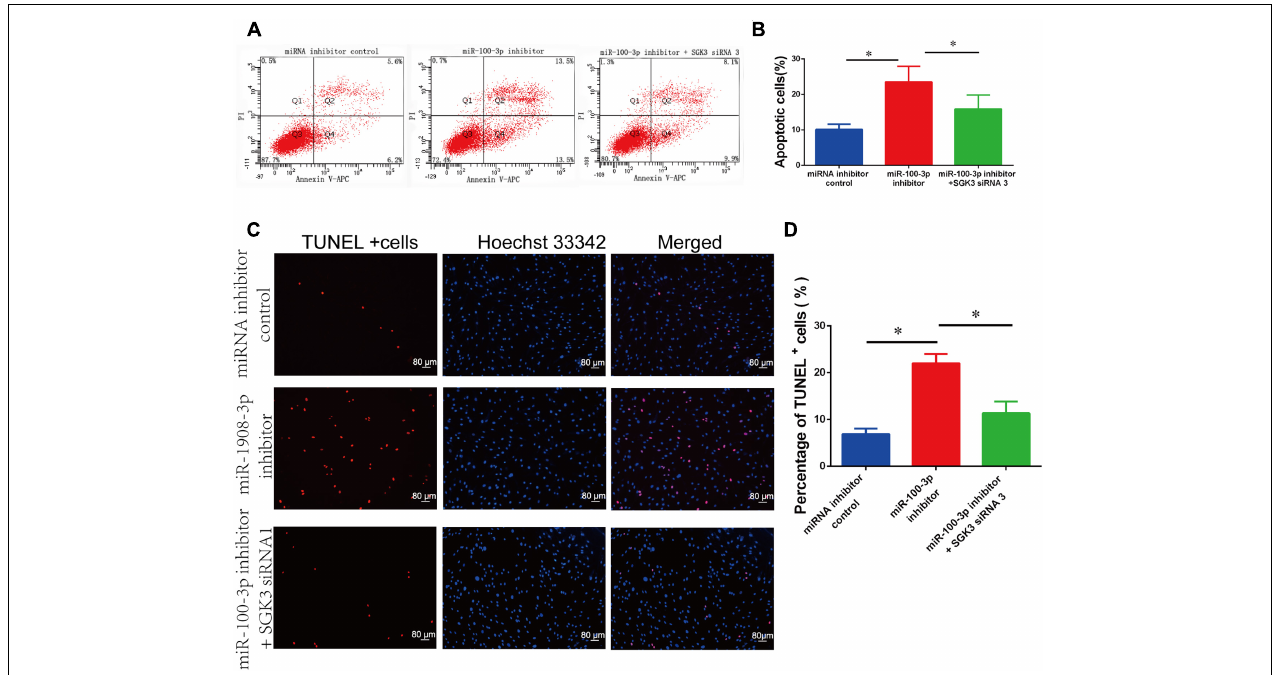
FIGURE 7 | The impact of miR-100-3p and serum/glucocorticoid regulated kinase family member 3 (SGK3) siRNA 3 on the apoptosis of human Sertoli cells. (A,B) Allophycocyanin (APC) Annexin V/propidium iodide (PI) staining and flow cytometry showed the apoptotic percentages of human Sertoli cells affected by miRNA inhibitor control, miR-100-3p inhibitor, as well as miR-100-3p inhibitor and SGK3 siRNA 3. (C,D) Terminal deoxynucleotidyl transferase dUTP nick end labeling (TUNEL) assay revealed the percentages of TUNEL-positive cells in human Sertoli cells affected by miRNA inhibitor control, miR-100-3p inhibitor, as well as miR-100-3p inhibitor and SGK3 siRNA 3. Scale bar in panel (C) = 80 µ m. * indicates the statistical differences between miR-100-3p inhibitor and SGK3 siRNA 3 and miR-100-3p inhibitor or between miR-100-3p inhibitor and miRNA inhibitor control.